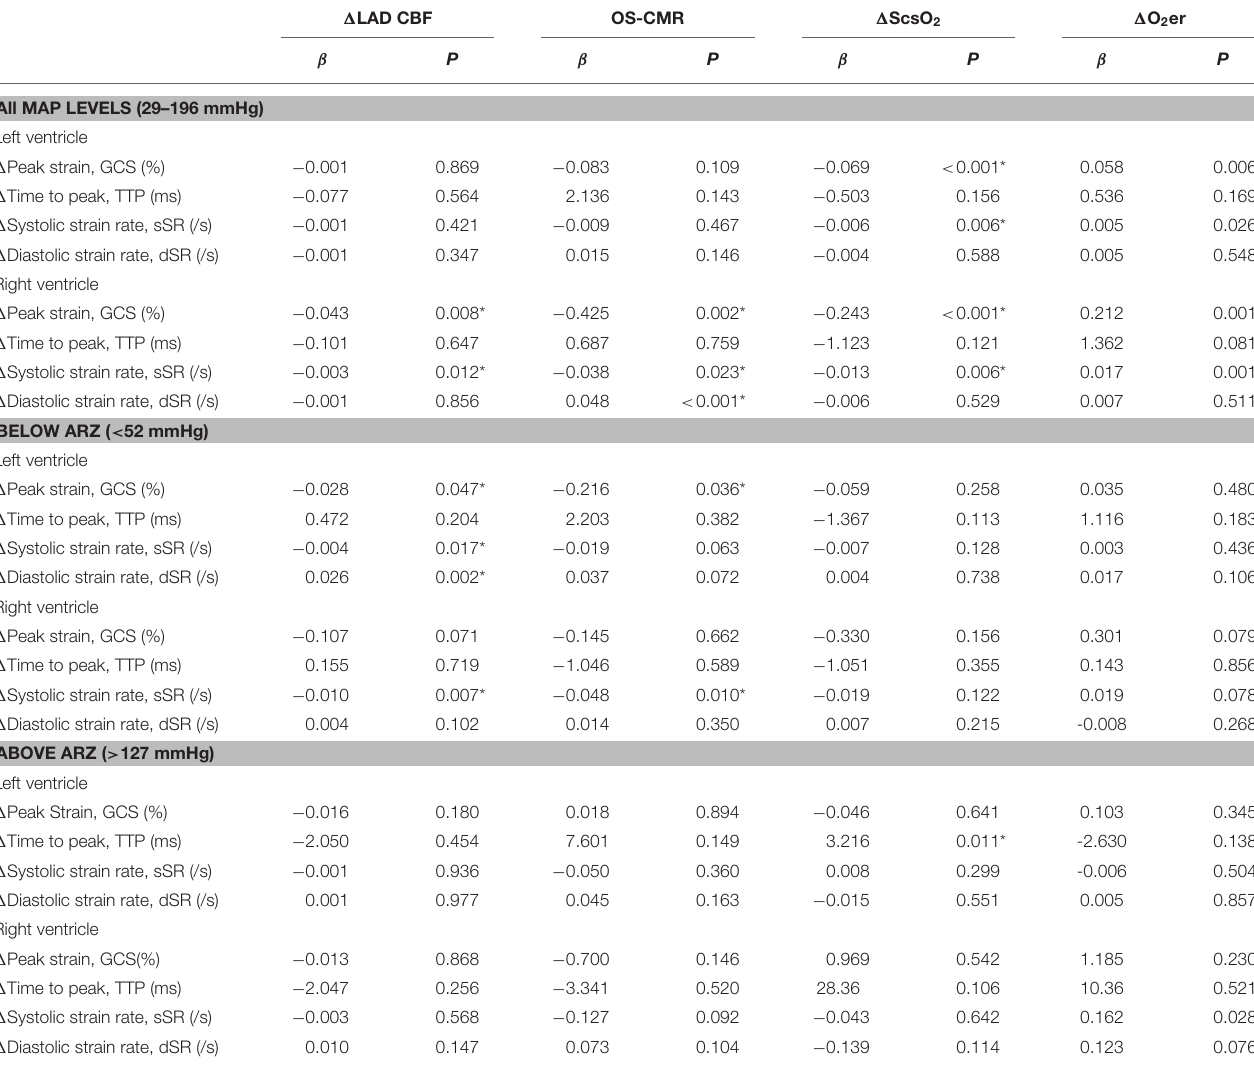
TABLE 2 | Association of FT and oxygenation measurements outside the autoregulation